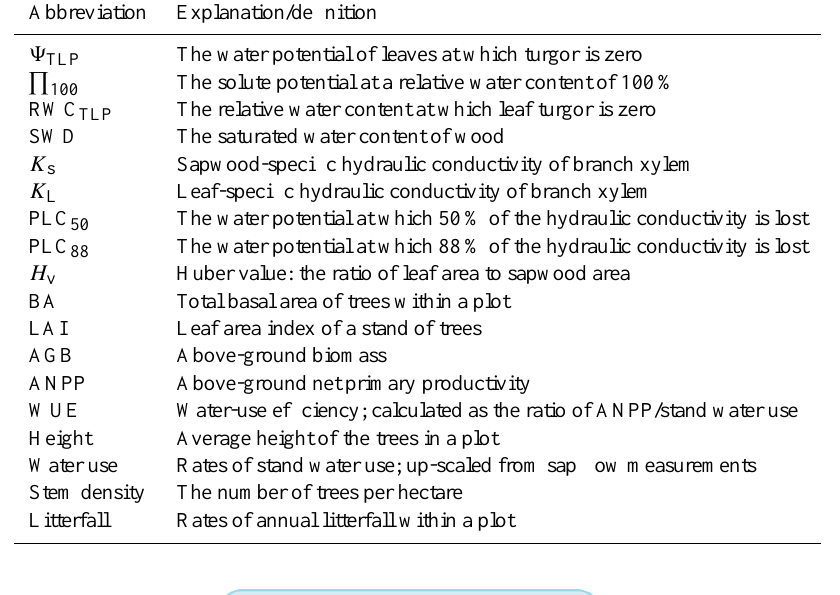
Table 4. The meaning of the abbreviations/traits used in Fig. 7.